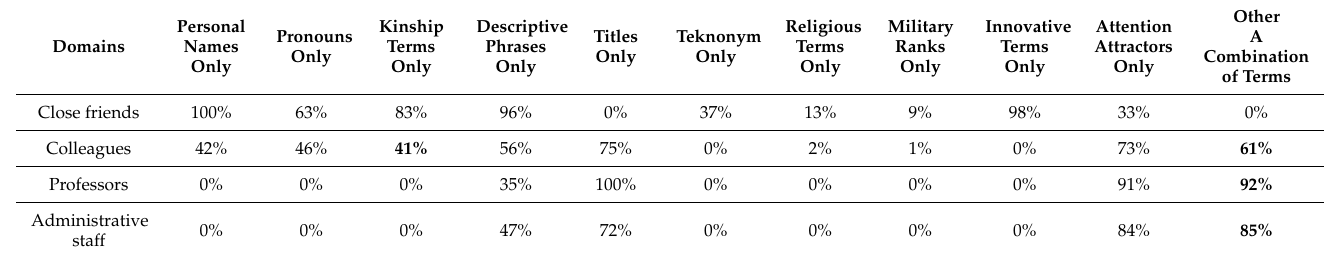
Table 2. Key address terms used by university students.